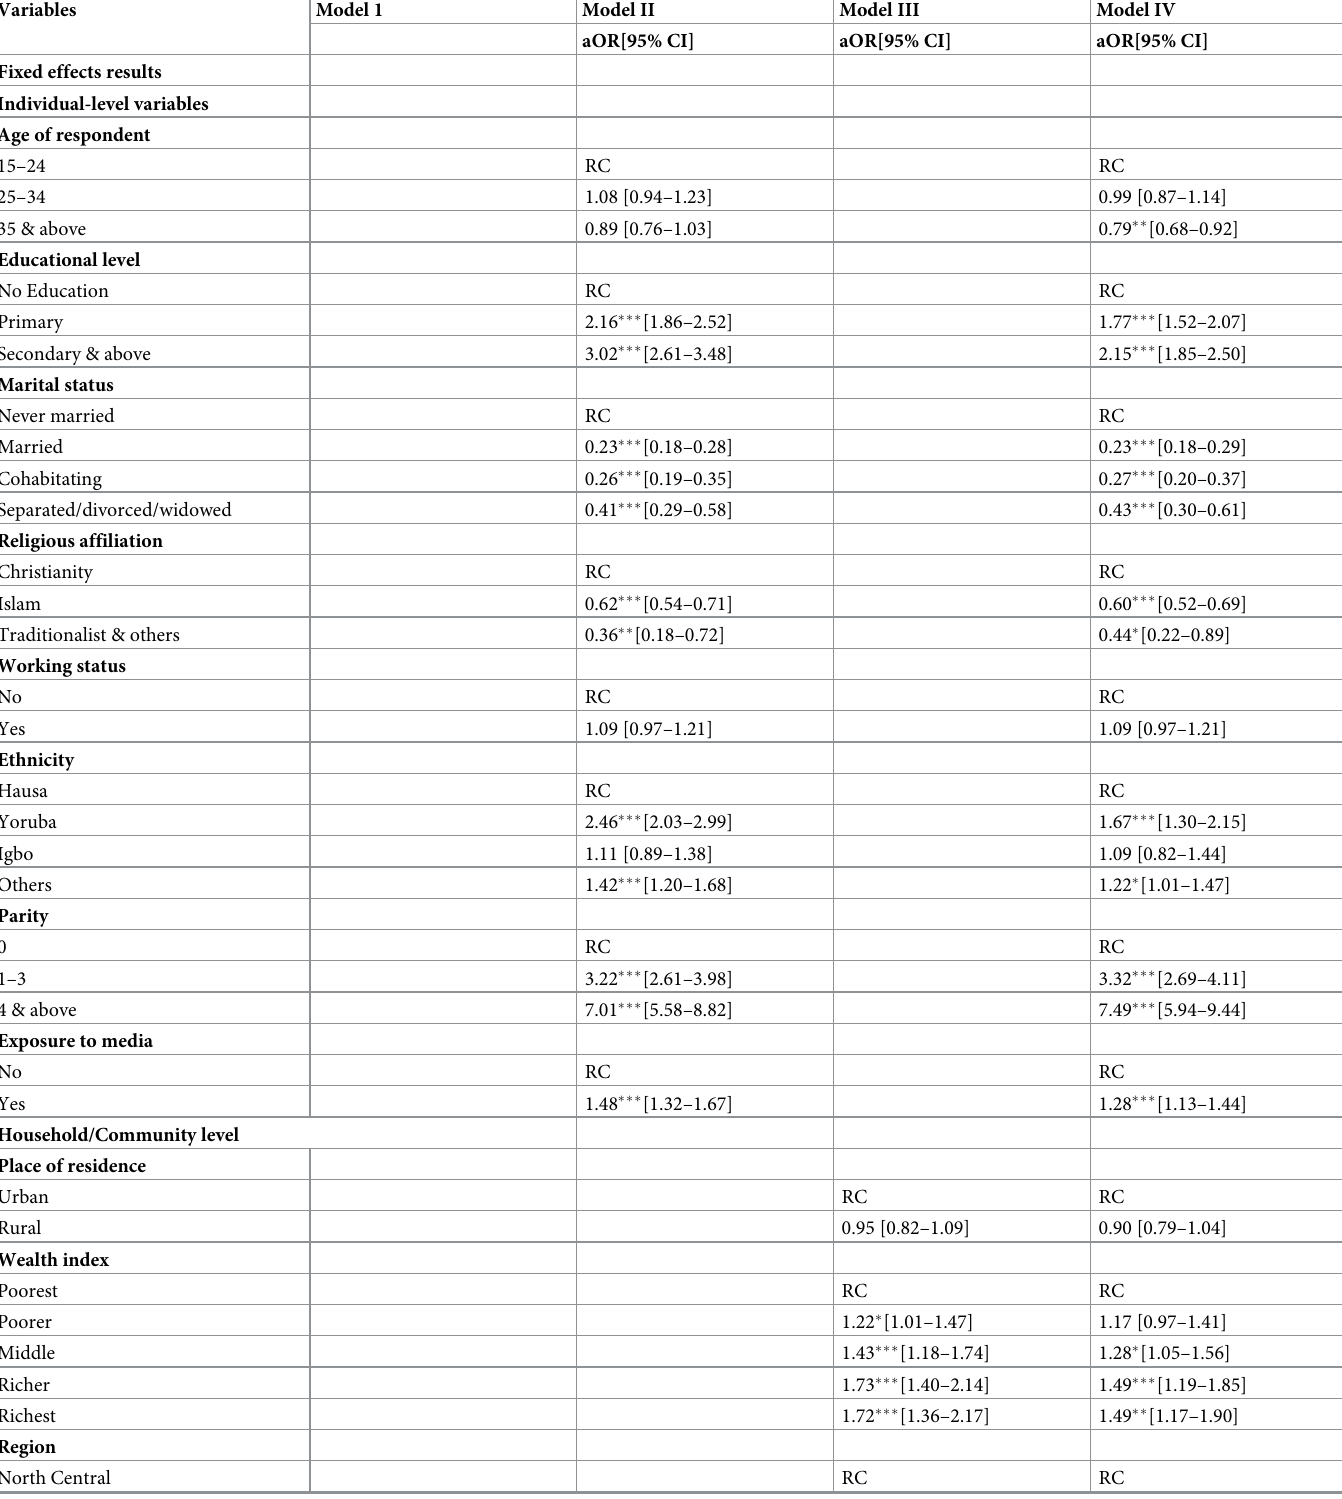
Table 2. Multilevel logistic regression models for individual and household/community predictors of modern contraceptive